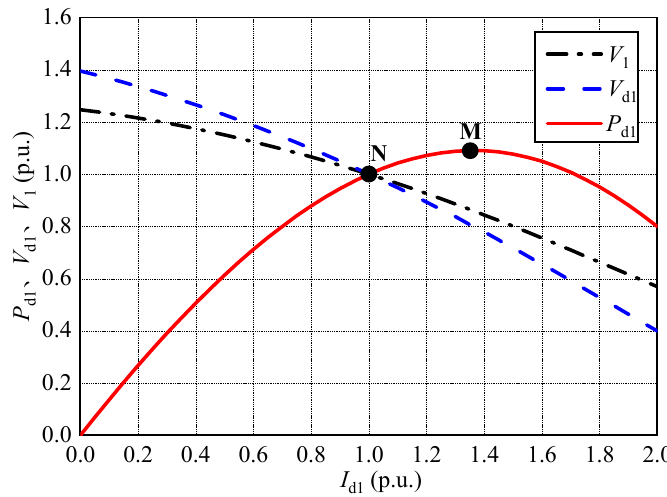
Figure 2. Curves of V 1 , V d1 and P d1 versus I d1 of LCC-HVDC.